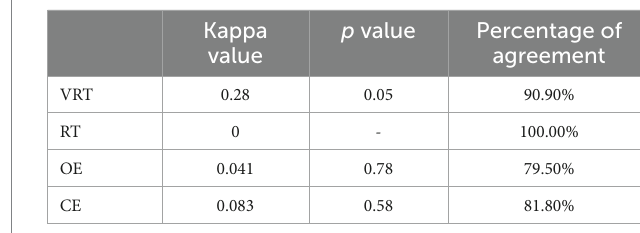
TABLE 6 Percentage of clinical agreement between testing across time (test vs. retest) for the Brazilian participants, with the Kappa agreement